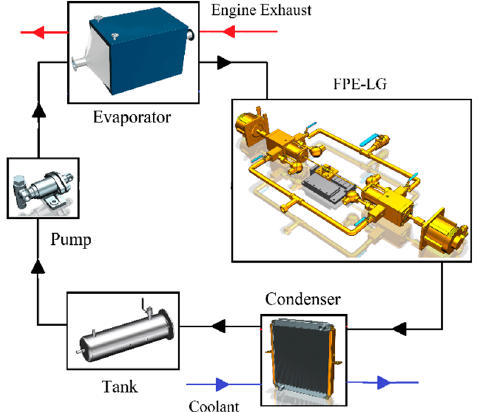
Figure 2. Schematic diagram of small ‐ scale Organic Rankine Cycle (ORC) system using FPE ‐ LG.